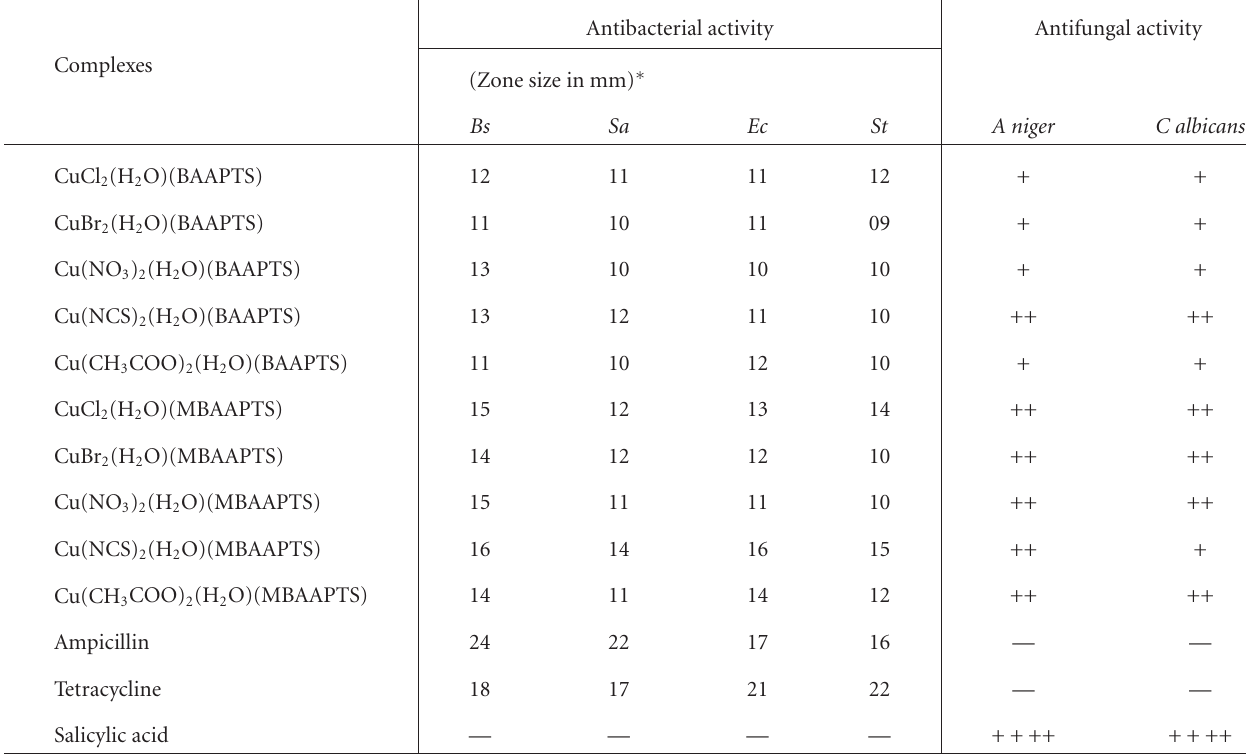
Table 2: Antibacterial and antifungal activities of copper(II) complexes of BAAPTS and MBAAPTS.